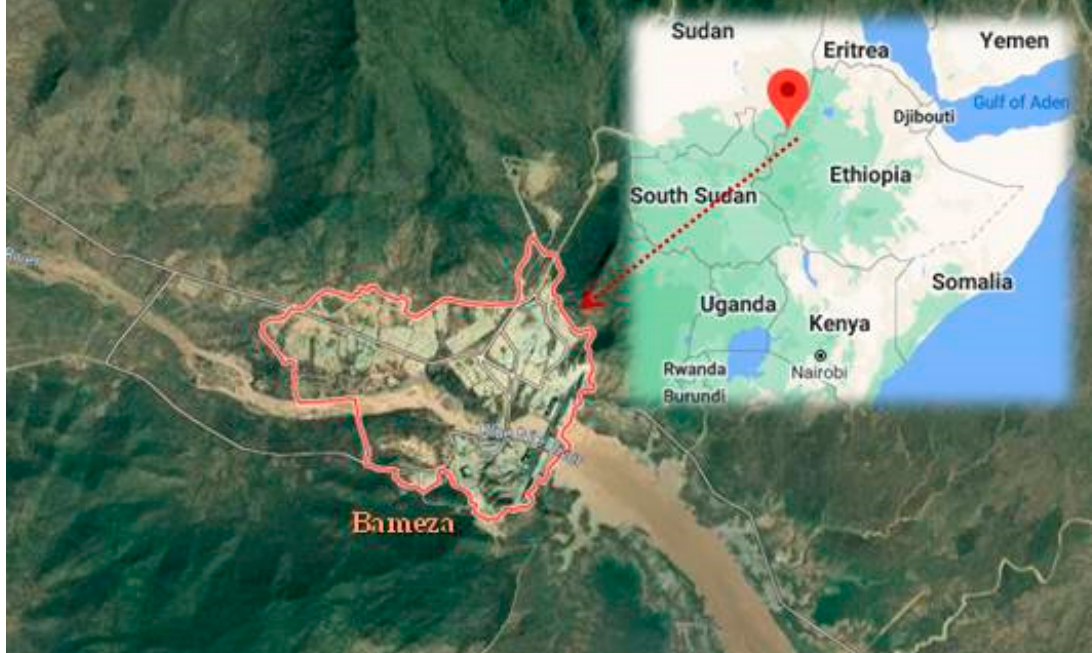
Figure 1. Map of the studied area (Bameza in the Benishangul-Gumuz region along the Blue Nile in north-western Ethiopia, Africa).